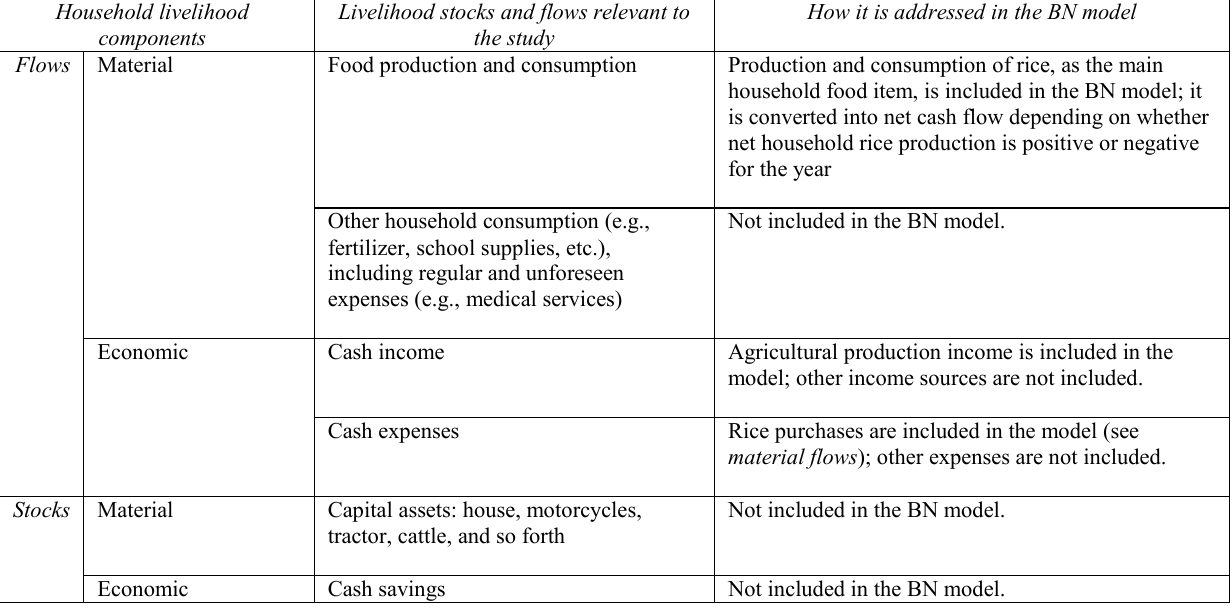
Table A1.4: Household livelihood conceptualization: the sum of a household’s material and economic stocks and flows Household